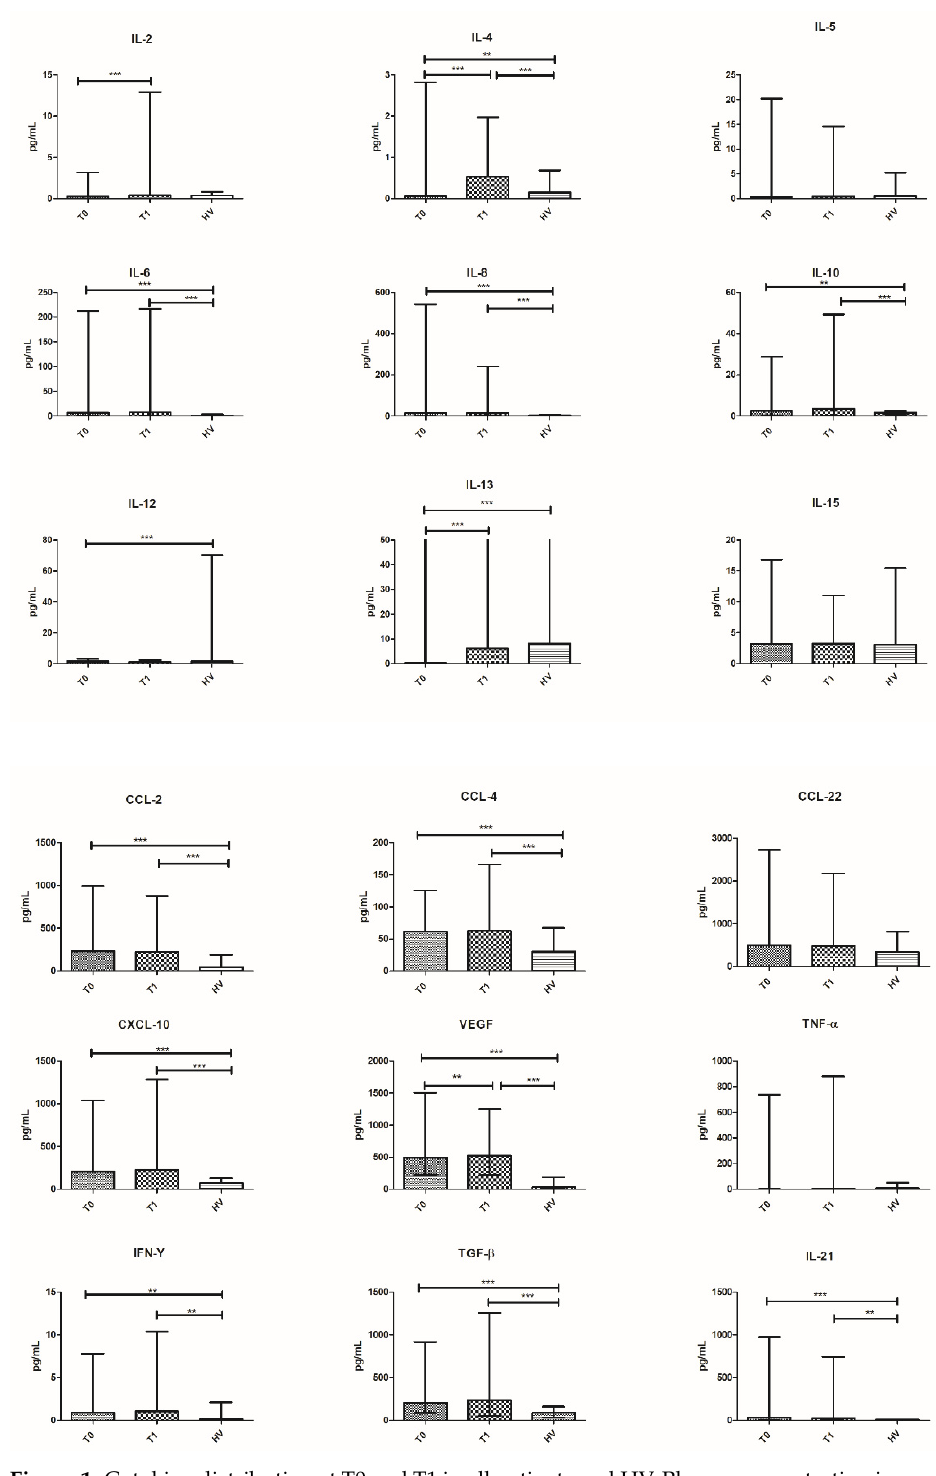
Figure 1. Cytokine distribution at T0 and T1 in all patients and HV. Plasma concentration is expressed in pg/mL and plotted on the y -axis; time points are on the x -axis. Data are expressed as median with range. *** p < 0.001, ** p < 0.01, * p < 0.05. CCL, C-C motif ligand; IL, interleukin.